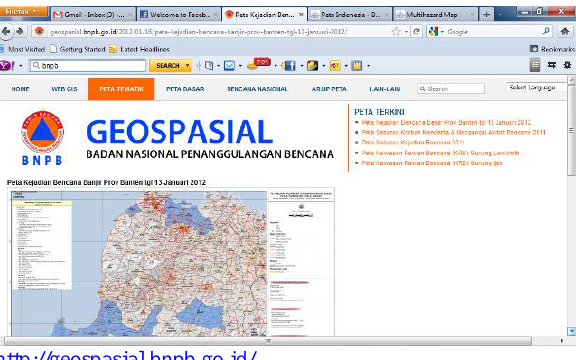
Figure 7. Geospasial BNPB (National Disaster Agency